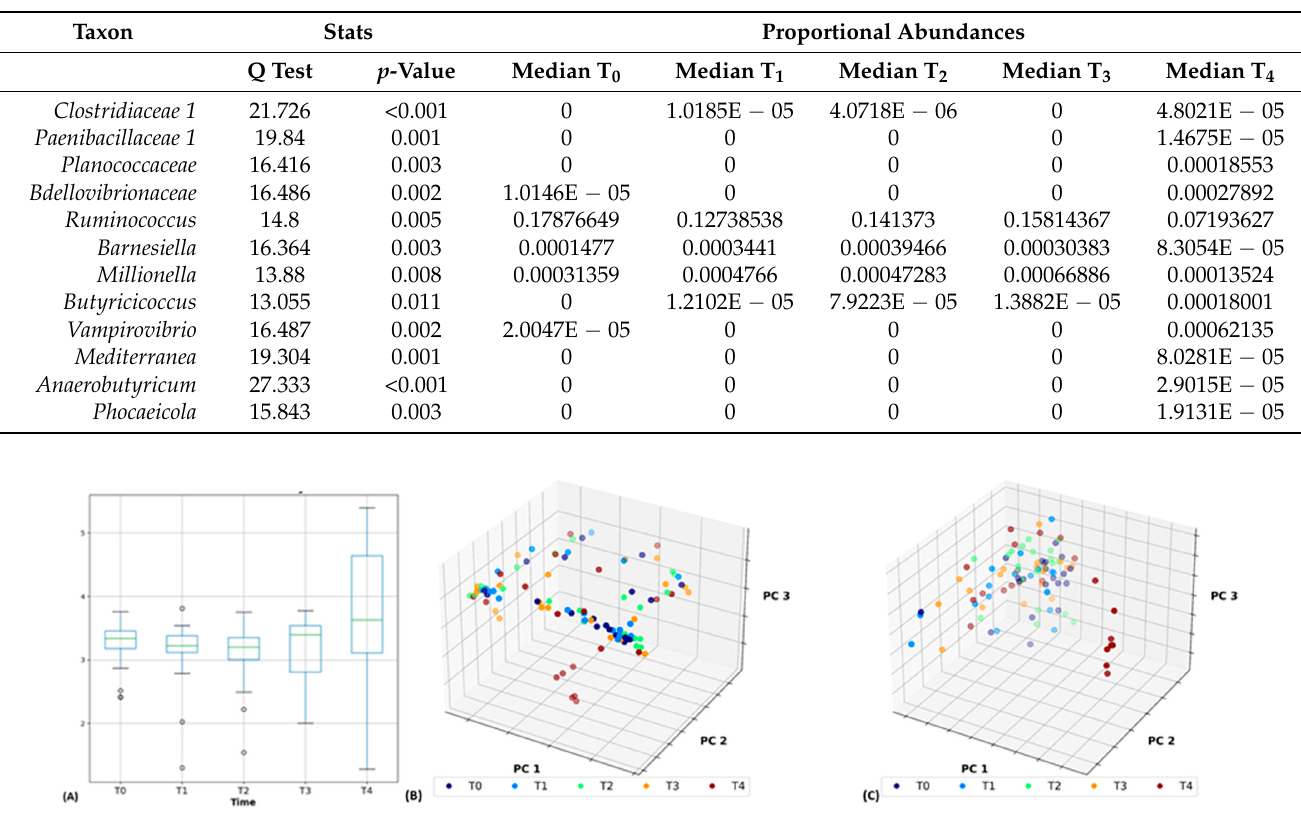
Figure 2. ( A ) Shannon diversity exhibited a trend toward significance with greater diversity driven by greater diversity being present at T4 than at T2 ( p = 0.066). ( B ) Bray Curtis dissimilarity ( p = 0.018), and ( C ) Jaccard distance ( p = 0.001) demonstrate distinct groupings at T4.